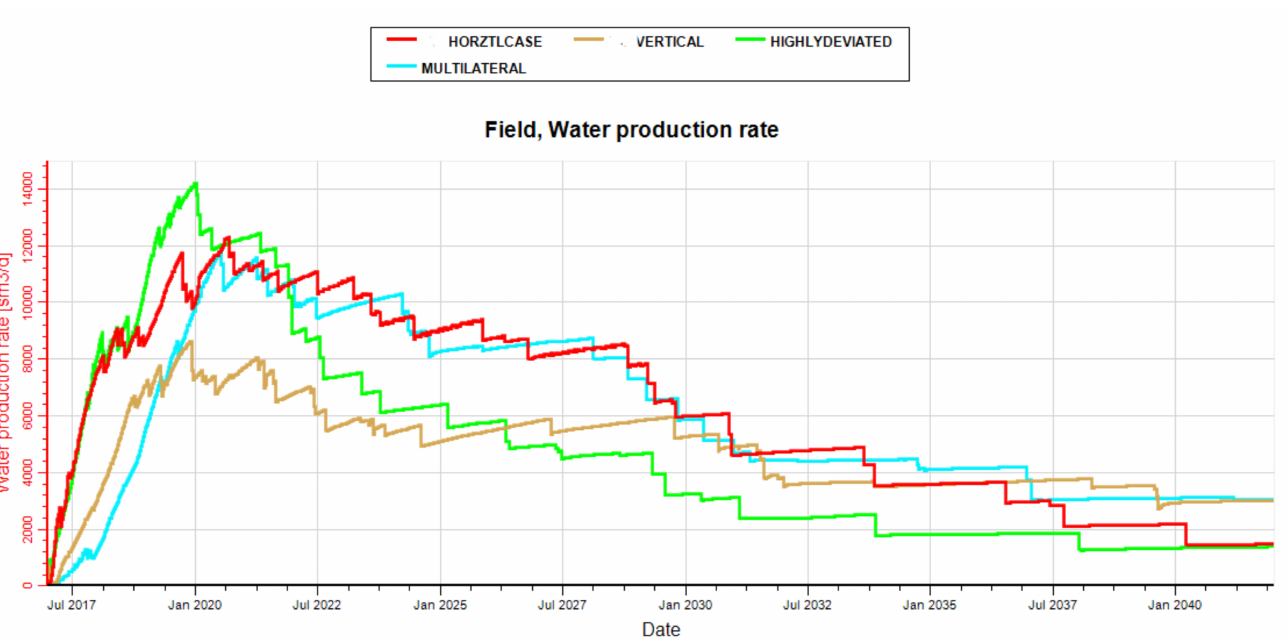
Figure 13. Field water production rate for each well